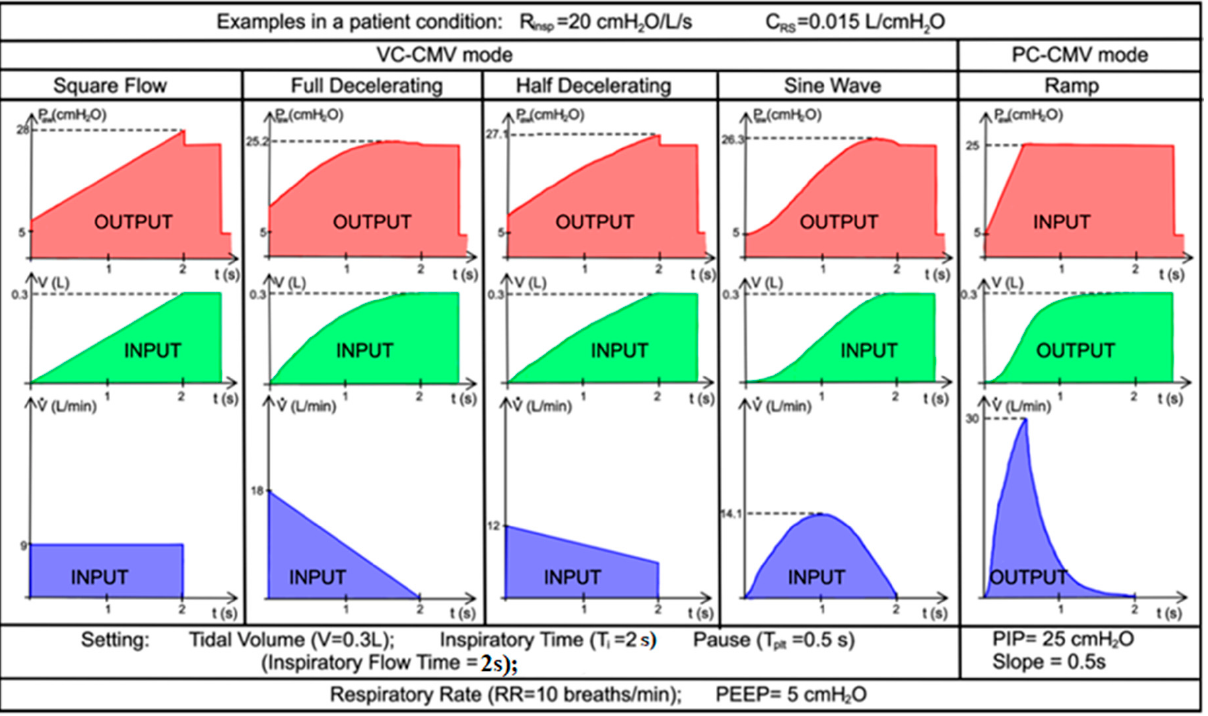
Figure 21. Case 2. Recorded real − life trends of flow, volume, and pressure waveforms in VC − CMV and PC − CMV mode, adapted from [43].